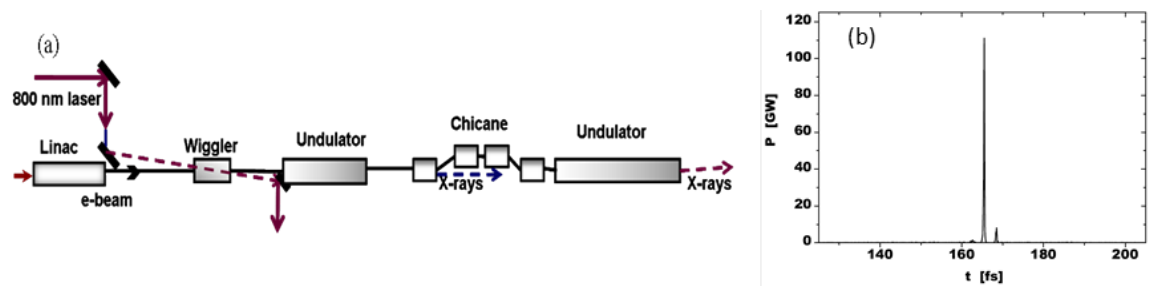
Figure 3. (Color online). Double undulator ESASE scheme. (a) The layout of the scheme. ( b ) Temporal structure of the radiation pulse after monochromator